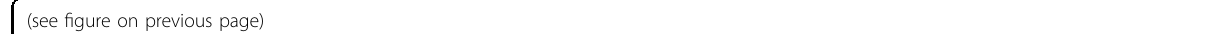
Fig. 3 Inhibition of CoCl 2 -induced apoptosis in PC12 cells by the treatment with TAT-Mcl-TM peptides. A – F Viability of CoCl 2 -treated PC12 cells pretreated with TAT-Mcl-TM-derived peptides. PC12 cells were transduced with 2 – 30 μ M TAT-Mcl-TM1 ( A ), TM2 ( B ), TM3 ( C ), TM4 ( D ), TM5 ( E ), or TM6 ( F ) for 2 h. Media were replaced with fresh media containing 0, 100, or 150 μ M CoCl 2 , and cells were incubated for 16 h. Cell viability was determined by MTT assay, and data are expressed as mean ± SD from at least three independent experiments. * p < 0.05, ** p < 0.01, *** p < 0.001. G Reduction of caspase-3 activation in CoCl 2 -treated PC12 cells by TAT-Mcl-TM peptides. PC12 cells were transduced with TAT-Mcl-TM peptides (10 μ M) for 2 h and then treated with 100 μ M CoCl 2 for 16 h. Cellular proteins were extracted from whole cells and subjected to immunoblotting to detect intact (35 kDa) and cleaved active caspase-3 (17 kDa). GAPDH was detected as the loading